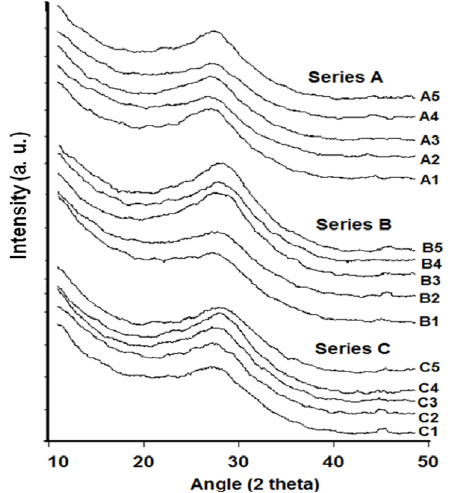
Figure 2. The XRD patterns of ternary zinc oxyfluoro tellurite glass